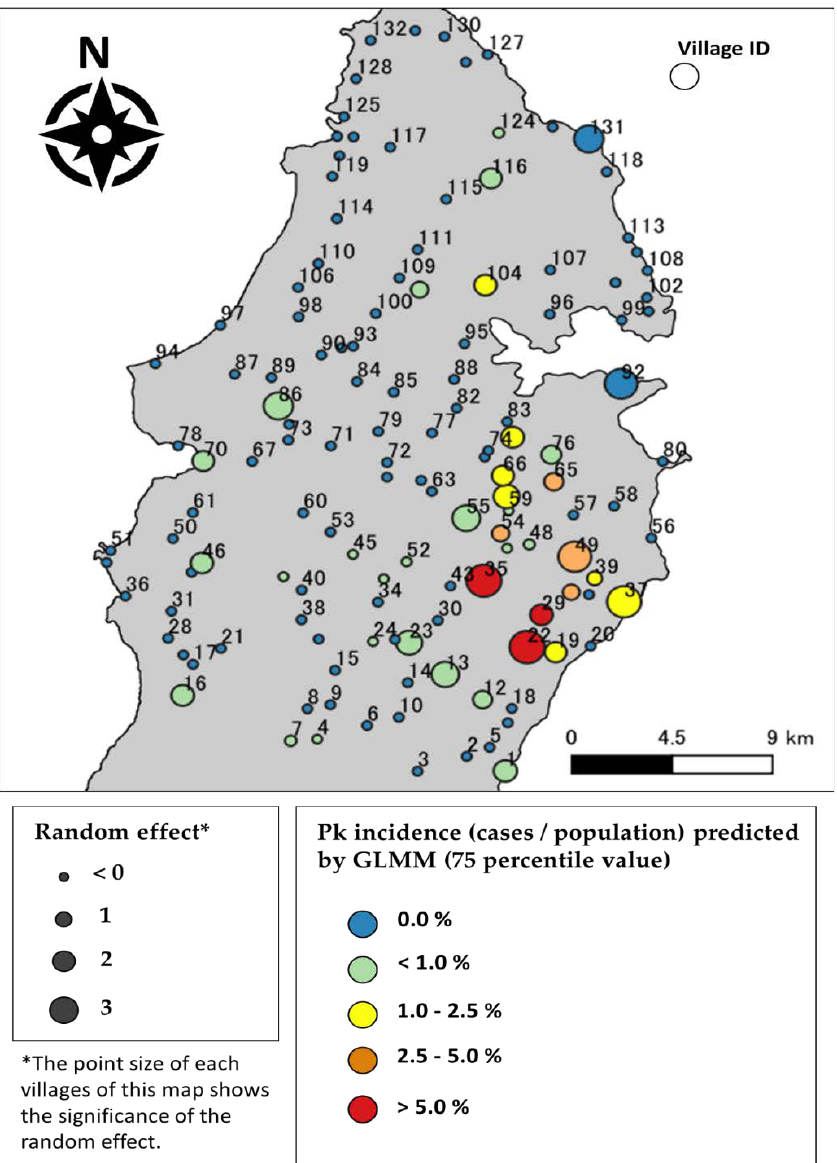
Figure 4. Pk malaria risk map of Kudat Peninsula. The map plots the generalised linear mixture model (GLMM) prediction value (75th percentile value of Markov chain Monte Carlo method (MCMC) sampling) of Pk malaria cases in each village. The Village IDs written on the map correspond to the Village IDs of Figure 3.